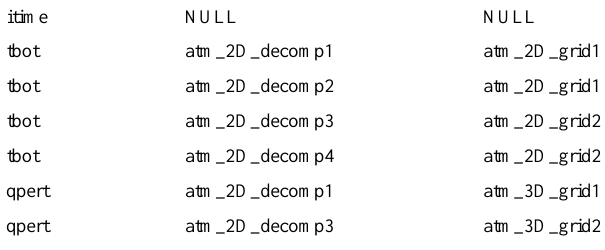
Figure 3. A configuration file for an atmospherical model to register field instances to the C-10